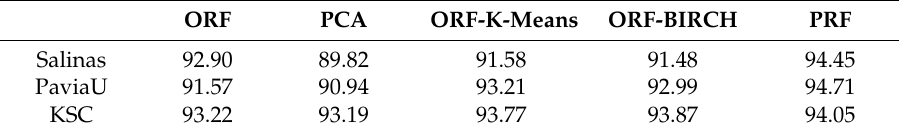
Table 7. Optimal classification results based on different dimensionality reduction methods.